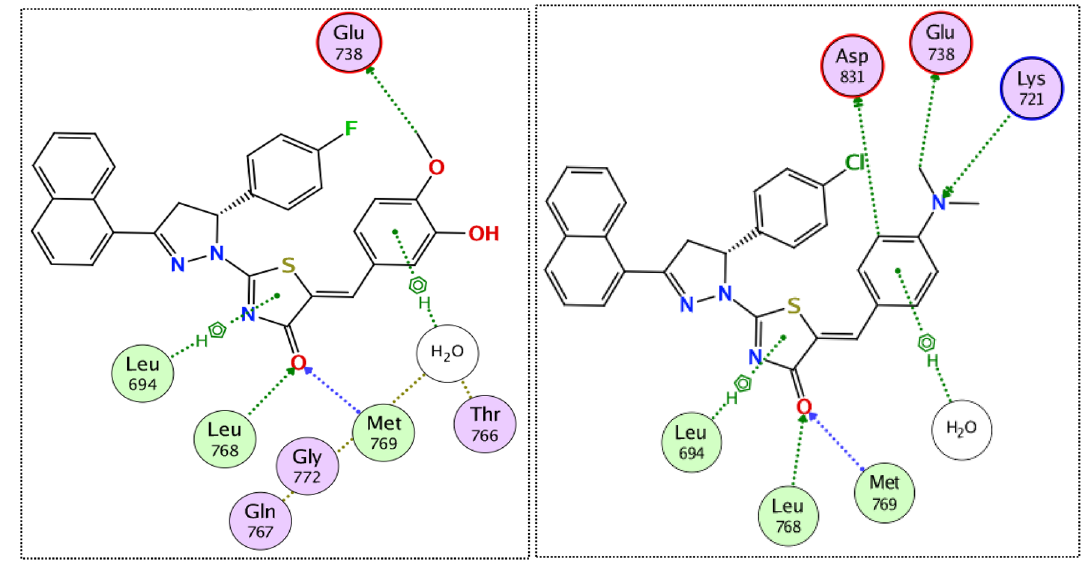
Figure 5. The 2D interaction diagram of EGFR receptor with 9g (left) 9k (right).